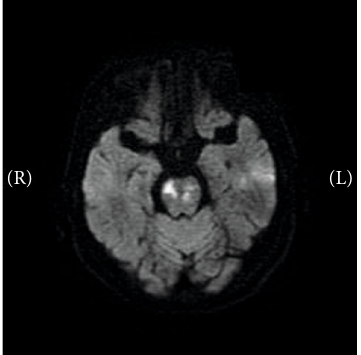
Figure 5: Multiple brainstem stroke.